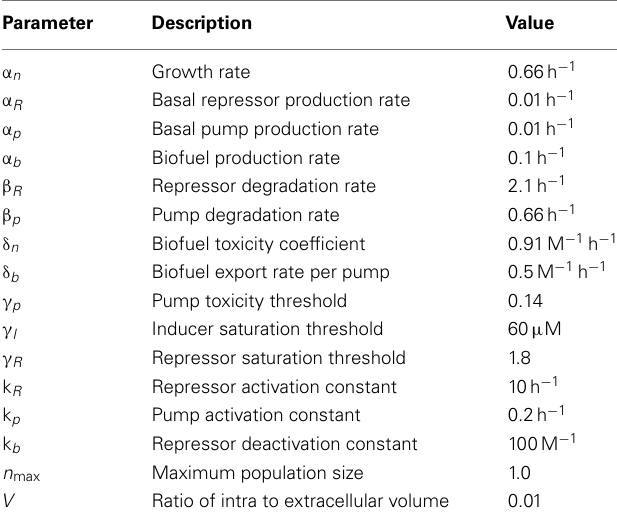
Table 1 | Parameter values for feedback control